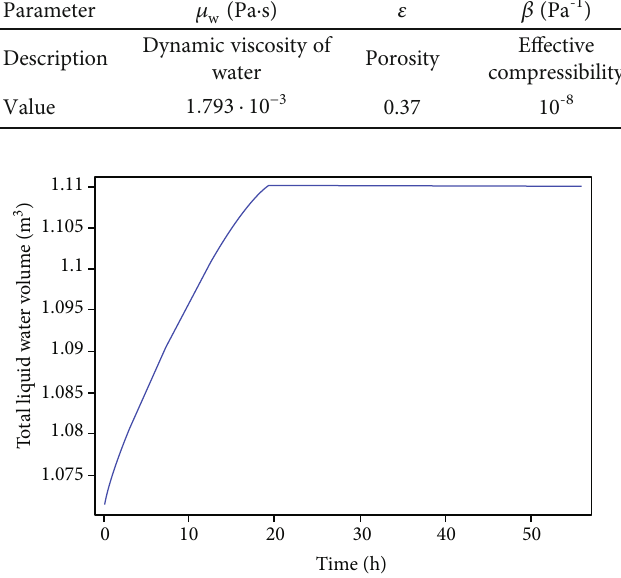
Figure 2: Total liquid water volume. Display the variation of total liquid water volume in the thawing process.